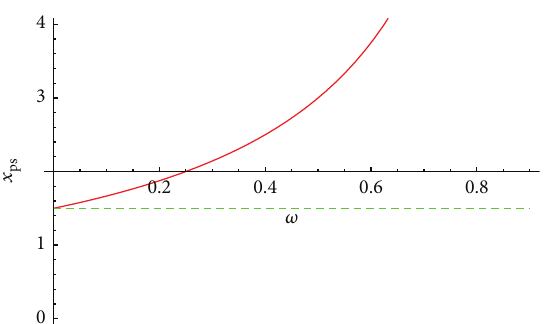
) for the string cloud versus ps whereas the green ps